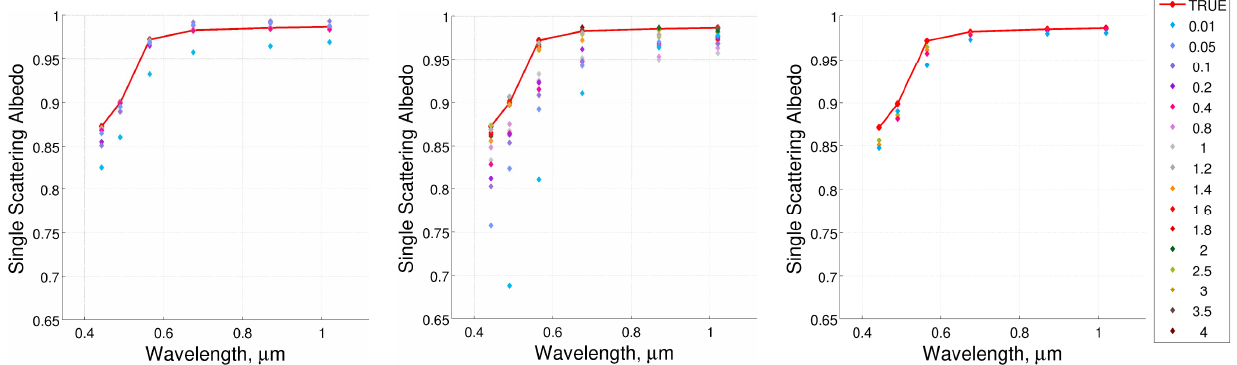
Fig. 14. Retrieval of desert dust single scattering albedo over Banizoumbou for 16 different aerosol loadings from τ (0.44µm)=0.01 to 4.0: (left panel) single-pixel retrieval with no noise added; (center panel) single-pixel retrieval with the random noise added; (right panel) multi-pixel retrieval with the random noise added. 1